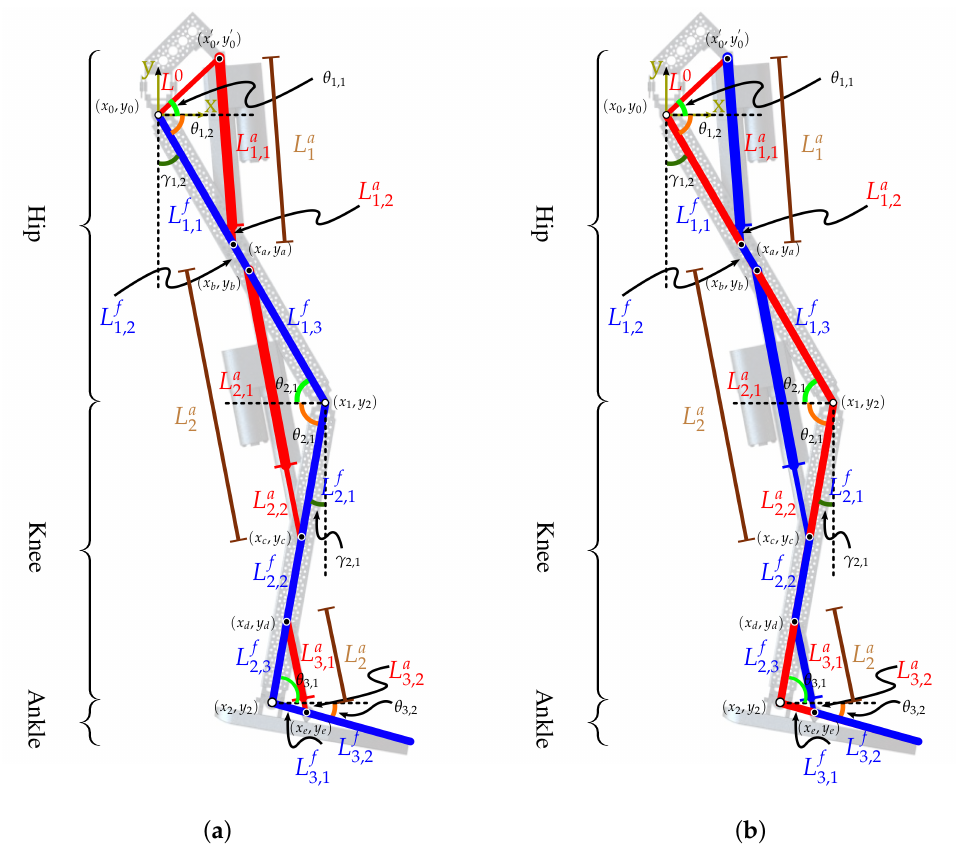
Figure 1. Models considered for the BRD assuming the two configurations for the linear actuators forming a structure in the device. ( a ) Comparison of trajectory tracking performance between the proposed and PID controllers at the hip joint in the biped robot; ( b ) comparison of trajectory tracking performance between the proposed and PID controllers at the hip joint in the biped